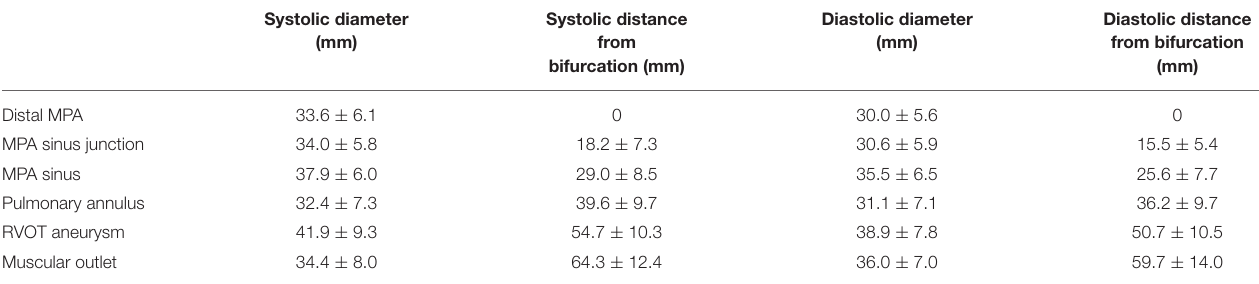
TABLE 2 | Multi-plane measurement based on 3D construction of CT.